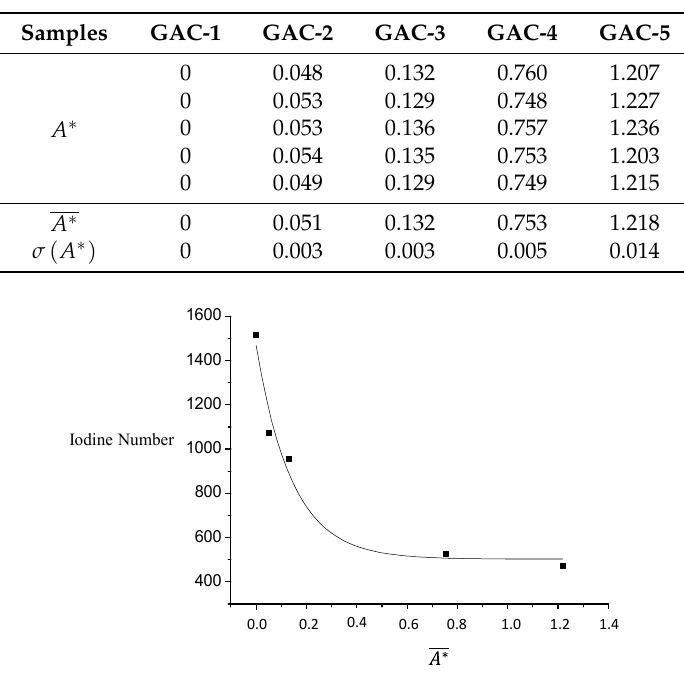
Figure 14. Relationship between the equilibrium absorption value and the iodine number.